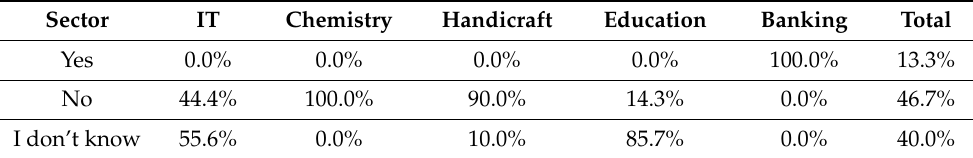
Table 5. Answers given to the question “Is your trademark registered?”.